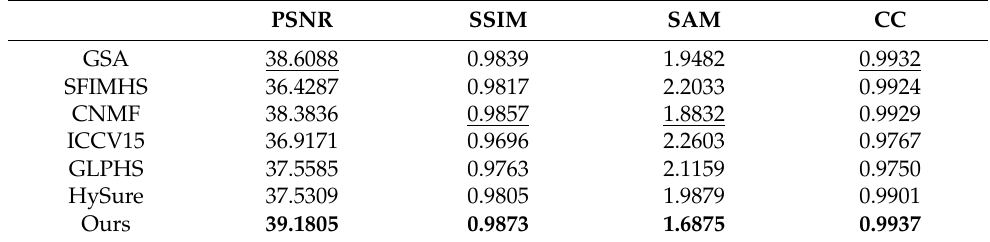
Figure 6. Results of Washington DC dataset with simulated multispectral images. ( a ) results of GSA; ( b ) results of SFIMHS; ( c ) results of GLPHS; ( d ) results of CNMF; ( e ) results of ICCV15; ( f ) results of HySure; ( g ) ours results; ( h ) Ground truth. Table 3. Quantitative evaluation results of Washington DC dataset with simulated multispectral